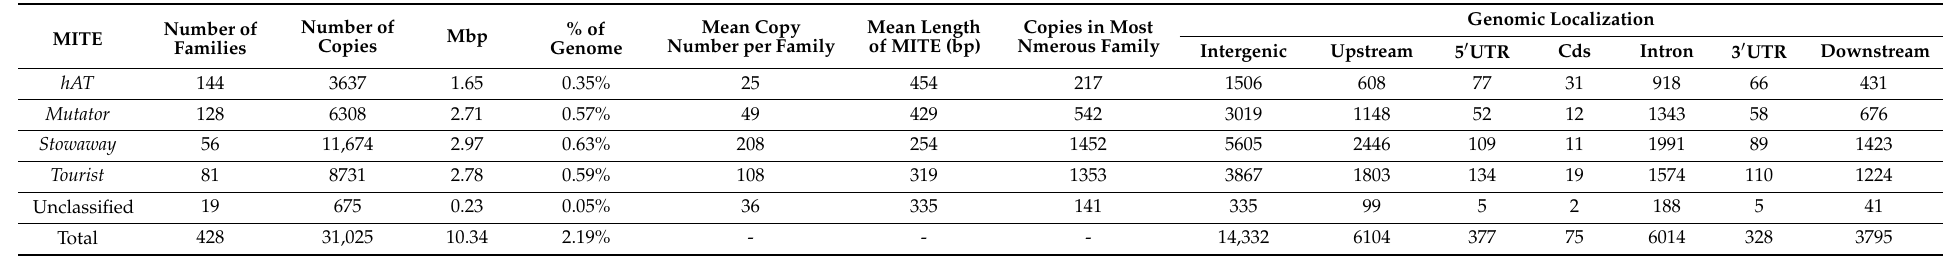
Table 1. MITEs identified in the carrot